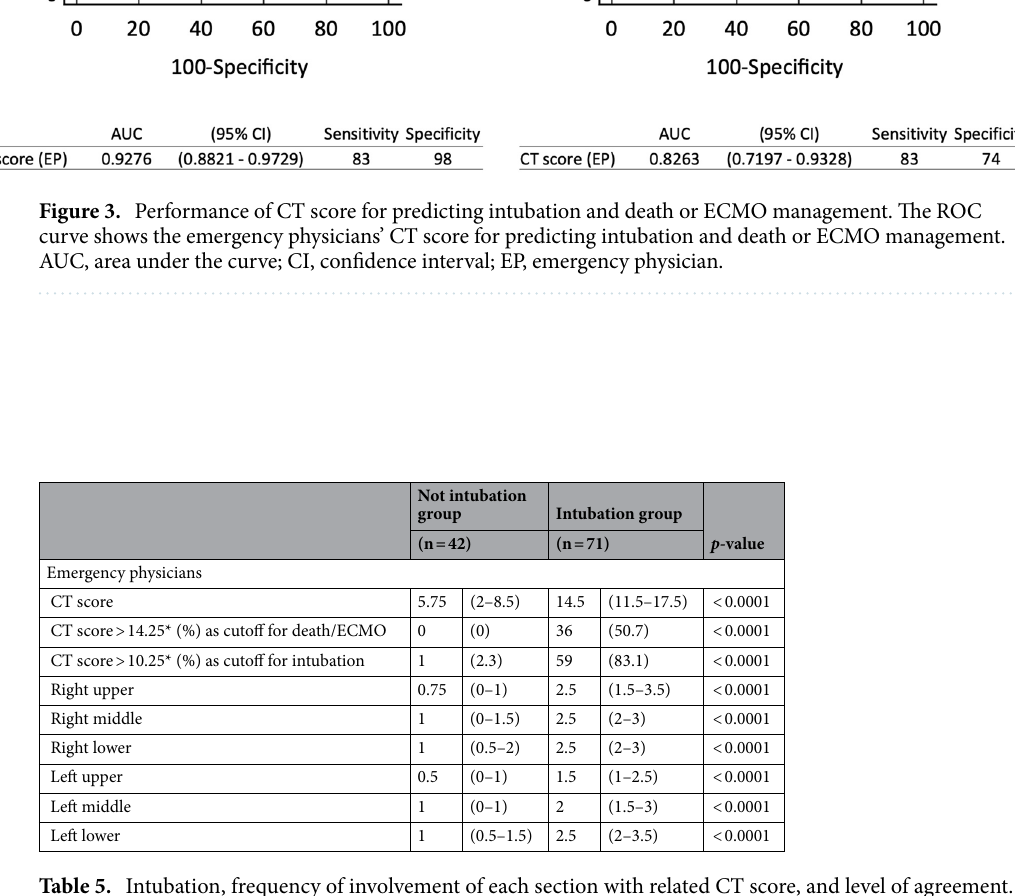
Table 5. Intubation, frequency of involvement of each section with related CT score, and level of agreement. *Frequency (%); Rest of data are presented as medians